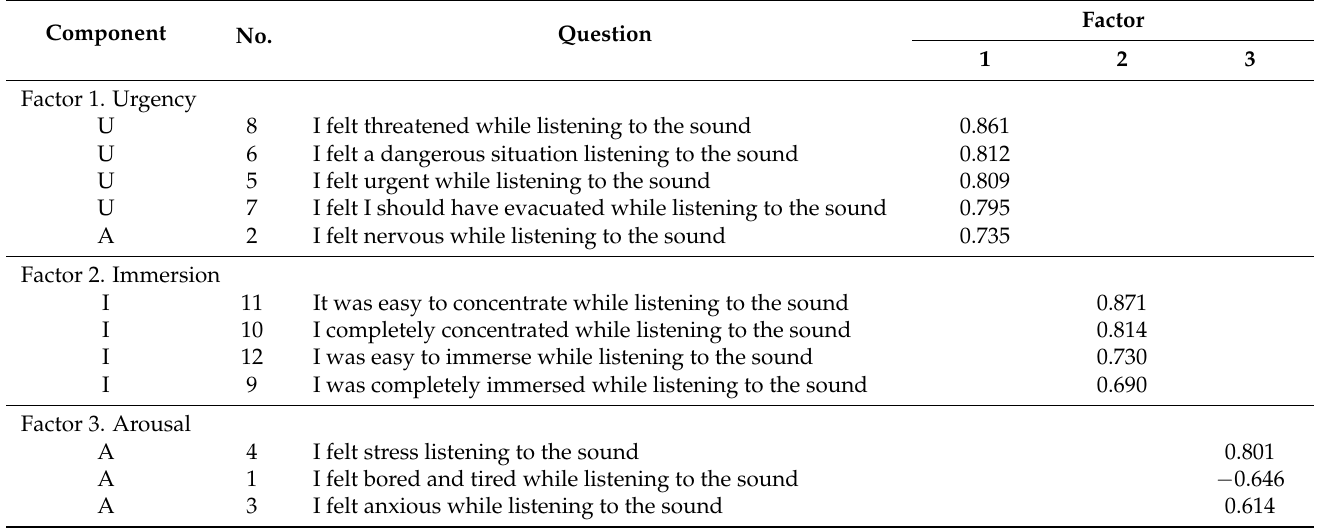
Table 1. Components Loadings from the Principle Component Analysis for the 12 Items of the Questionnaire; A: Arousal, I: Immersion, U: